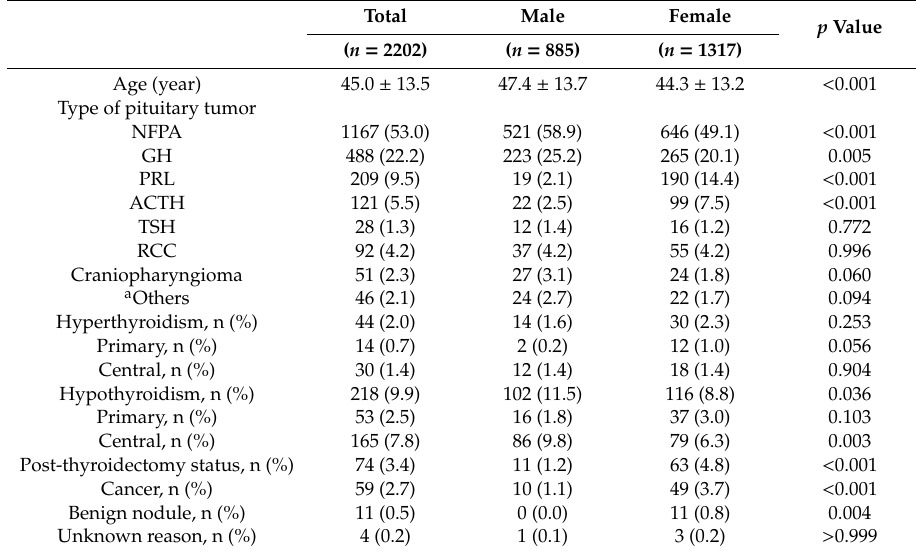
Table 1. Characteristics of the study population and prevalence of thyroid